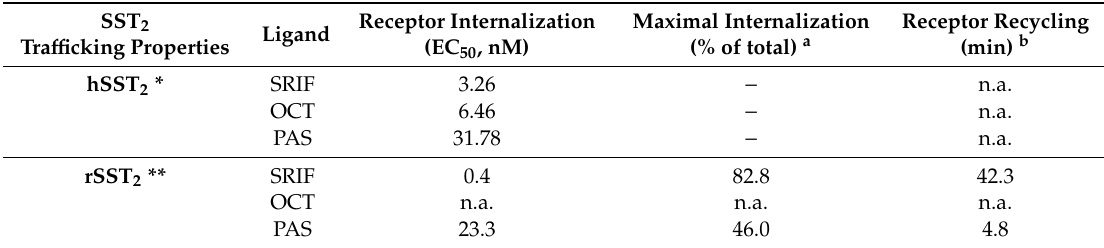
Table 1. Tra ffi cking properties of transfected human and rat somatostatin receptor subtype 2 (SST 2 ) after binding to endogenous somatostatin (SRIF), octreotide (OCT), and pasireotide (PAS). SST 2 Receptor Internalization Maximal Internalization Receptor Recycling Ligand Tra ffi cking Properties (EC 50 , nM) (% of total) a (min) b hSST 2 * SRIF 3.26 − n.a. OCT 6.46 − n.a. PAS 31.78 − n.a. rSST 2 ** SRIF 0.4 82.8 42.3 OCT n.a. n.a. n.a. PAS 23.3 46.0 4.8 hSST 2 , human SST 2 . rSST 2 , rat SST 2 . EC 50 , half-maximal e ff ective concentration. min, minutes. n.a. not assessed. In most preclinical studies, pasireotide (PAS) was named as SOM230.* Data about hSST 2 are reproduced